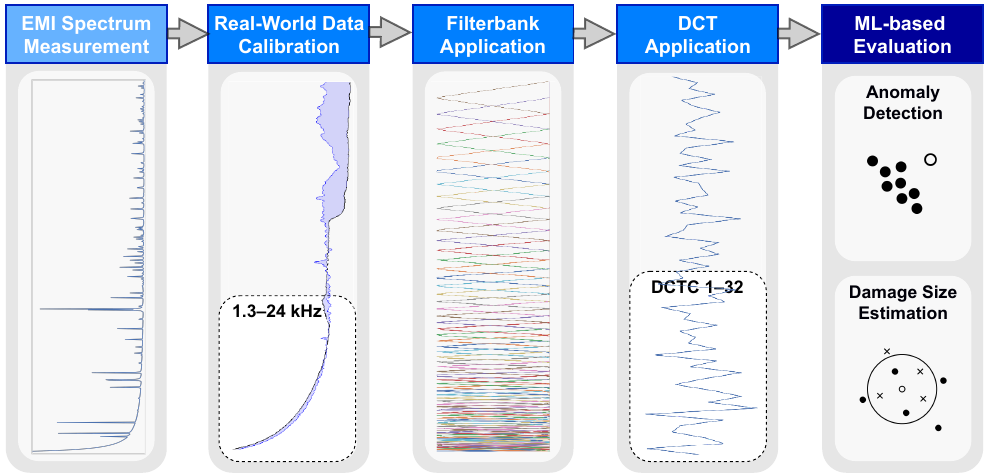
Figure 9. Flowchart of the preprocessing for real-world EMI data, where the original data